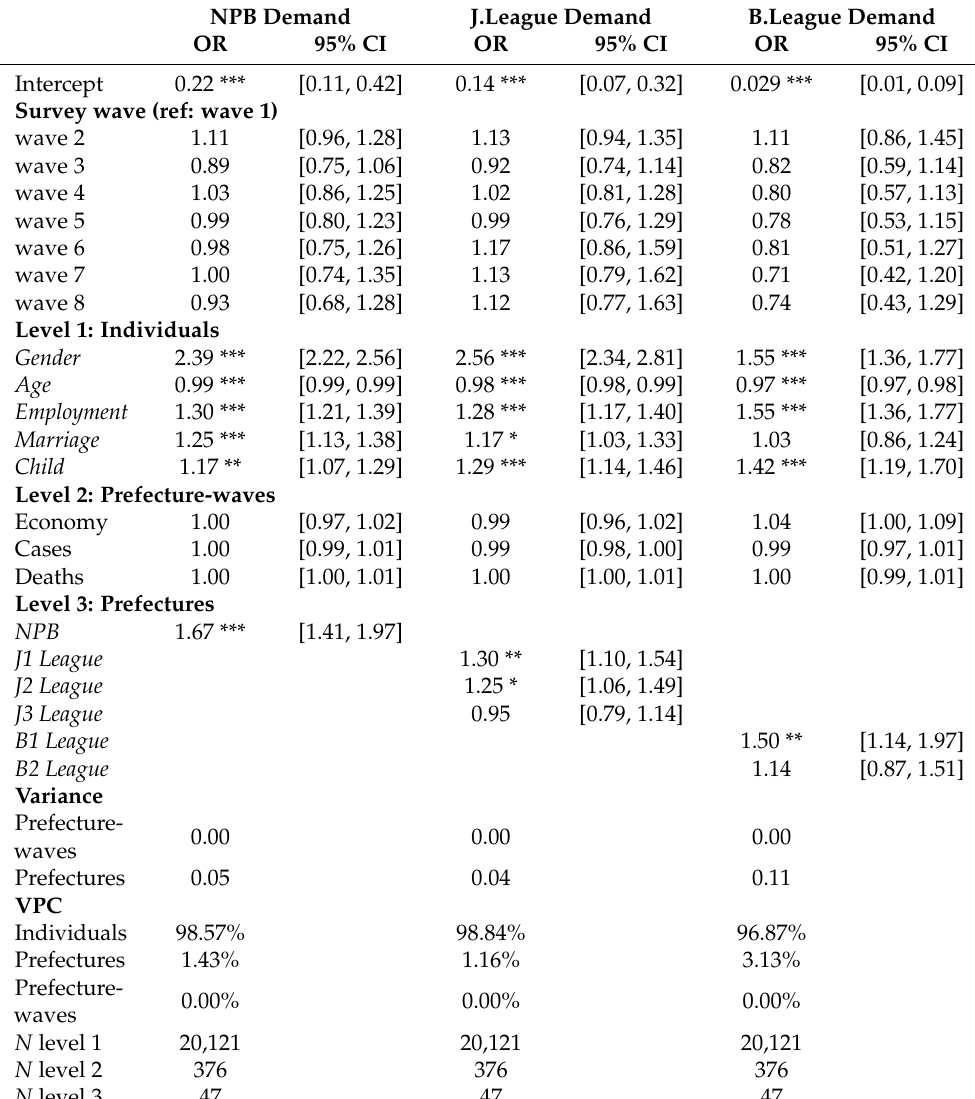
Table 4. Results of multilevel logistic regression on the relation between the three-level variables and spectator demand of Japanese citizens during the COVID-19